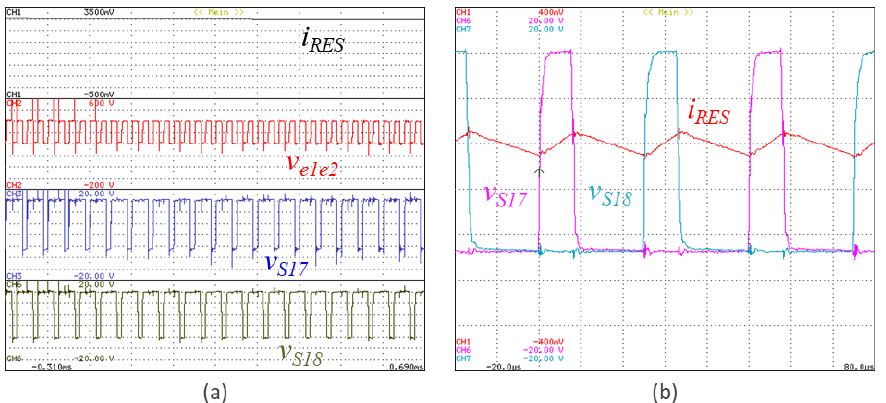
Figure 11. Experimental validation regarding the RES interface with the possibility to operate with three voltage levels, showing the RES current ( i RES ), the voltage of the unified topology ( v e 1 e 2 ) on the DC-side interface with the RES, and the gate-emitter voltage applied to the IGBTs S 17 and S 18 ( v geS 17 , v geS 18 ) to visualize the interleaved operation: ( a ) RES current, converter voltage, and the gate-emitter voltages of the IGBTs S 17 and S 18 ; ( b ) Detail of the RES current and the gate-emitter voltages of the IGBTs S 17 and S 18 .